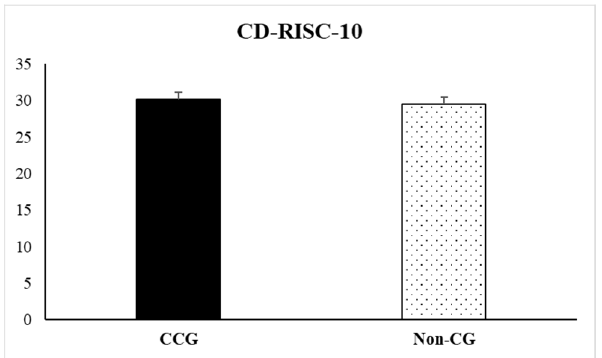
Figure 2. Scores obtained on the Perceived Stress Scale (PSS) by the informal cancer caregiver’s group (CCG) and the non-caregivers control group (Non-CG). Data are presented as mean ± SEM. (*) p < 0.01, CCG vs. Non-CG.